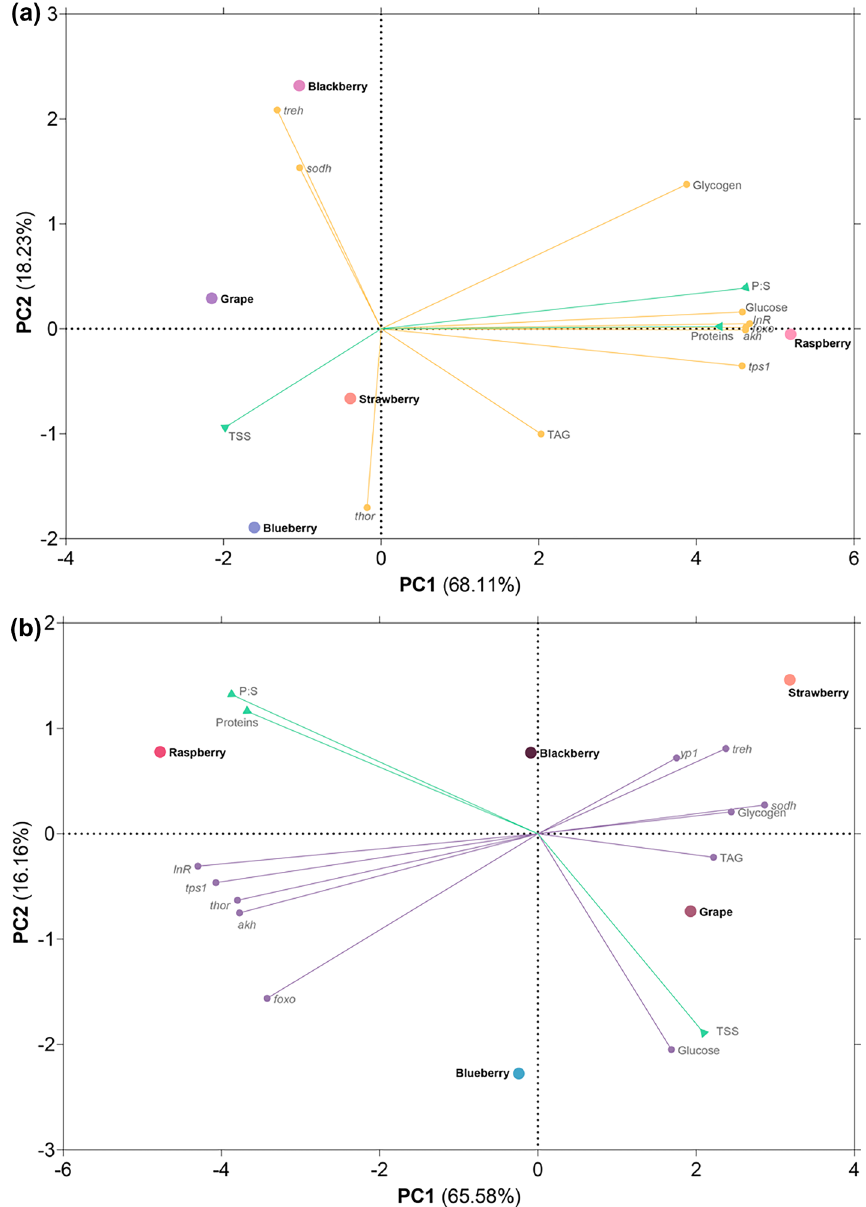
Figure 4. Principal component analysis of the results from fruit media analysis (green vectors) and SWD enzymatic quantification and gene expression. ( a ) results of males fed on the different fruit media (yellow vectors); ( b ) results of females fed on the different fruit media (purple